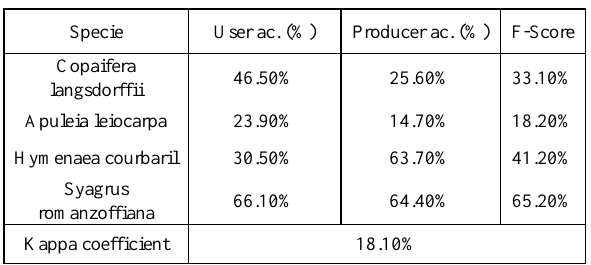
Table 4. Results of the validation set when RF model is applied in the pixel-based approach classification